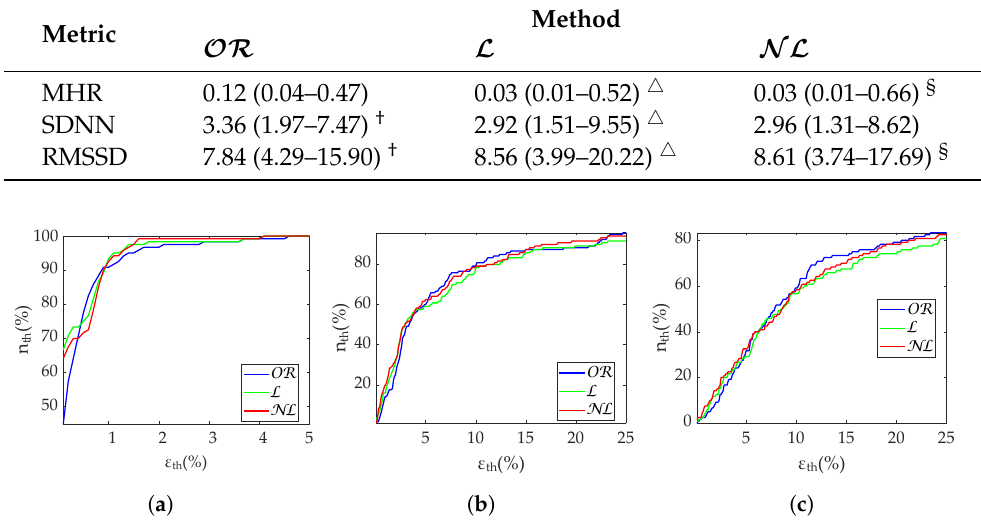
Figure 4. Coverage of time-domain metrics from Apple Watch dataset. ( a ) MHR. ( b ) SDNN. ( c ) RMSSD.